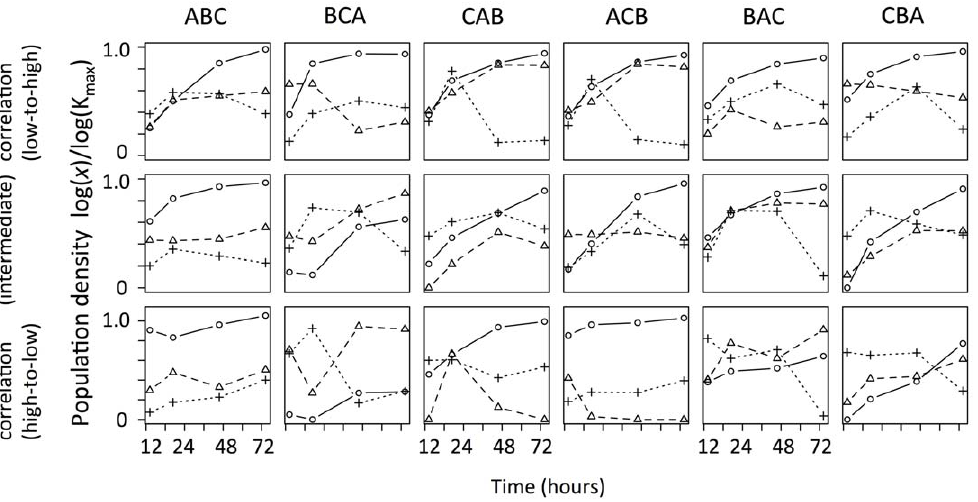
Figure 3. Population dynamics of the three protozoan species over 72 hours in the density (negative, control, and positive treatments; see Fig. 1) and sequence-of-introduction treatments. Densities were log e ( x + 1)-transformed and then scaled to log-transformed carrying capacity for each species, and three temporal blocks were averaged. Circles, species A; triangles, species B; crosses, species C. According to Fig. 2, we used 11000/mL for species A, 2500 for species B, and 550 for species C as estimates of carrying capacity for illustrative purpose. doi:10.1371/journal.pone.0042651.g003 PLoS ONE |